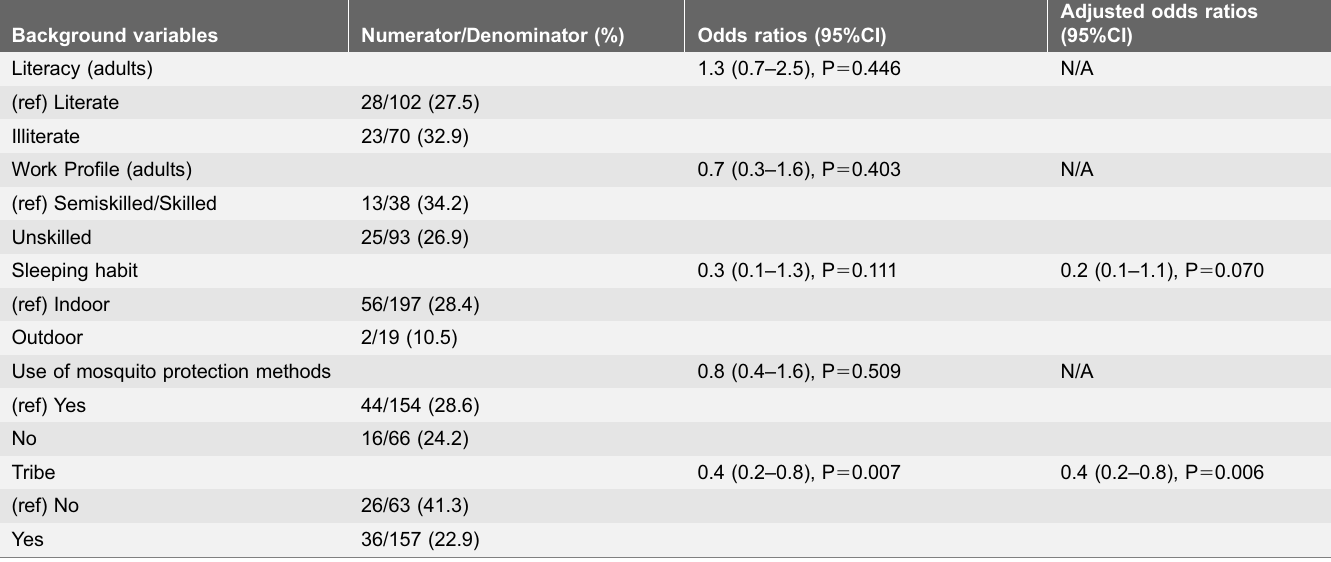
Table 4. Univariate and multivariate logistic regression analysis of different demographic and background variables associated with prognosis of enrolled complicated malaria patients admitted at Maharani Hospital Jagdalpur, Chhattisgarh,